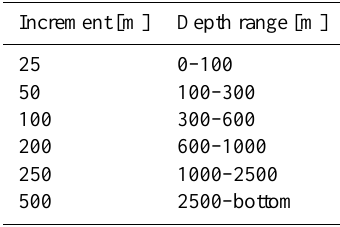
Table 1. Standard sampling depths of the M84/3 cruise in 2011.